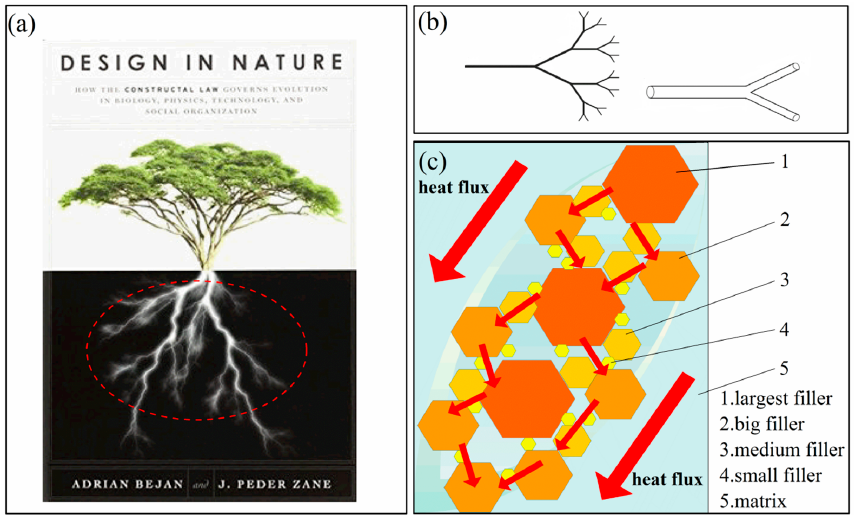
Figure 1. ( a ) A fractal root system of the tree [26]; ( b ) a classical constructal network; and ( c ) diagram of several-sized fillers filling in the matrix (2 dimensions).